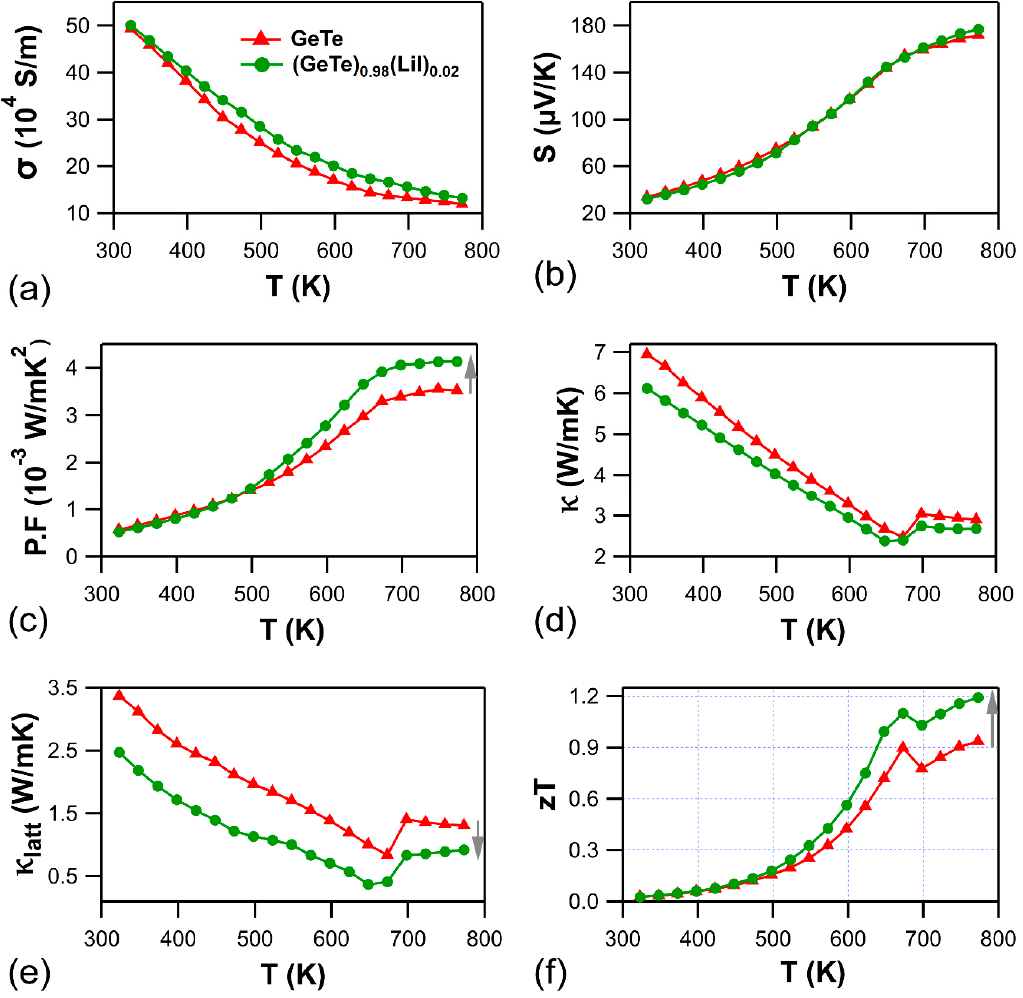
Figure 2. ( a ) Electrical conductivity, σ ; ( b ) Seebeck coefficient, S ; ( c ) power factor, P.F ; ( d ) total thermal conductivity, κ ; ( e ) lattice contribution to the thermal conductivity, κ latt ; and ( f ) thermoelectric figure of merit, zT , for the (GeTe) 1-x (LiI) x ( x = 0–0.02)